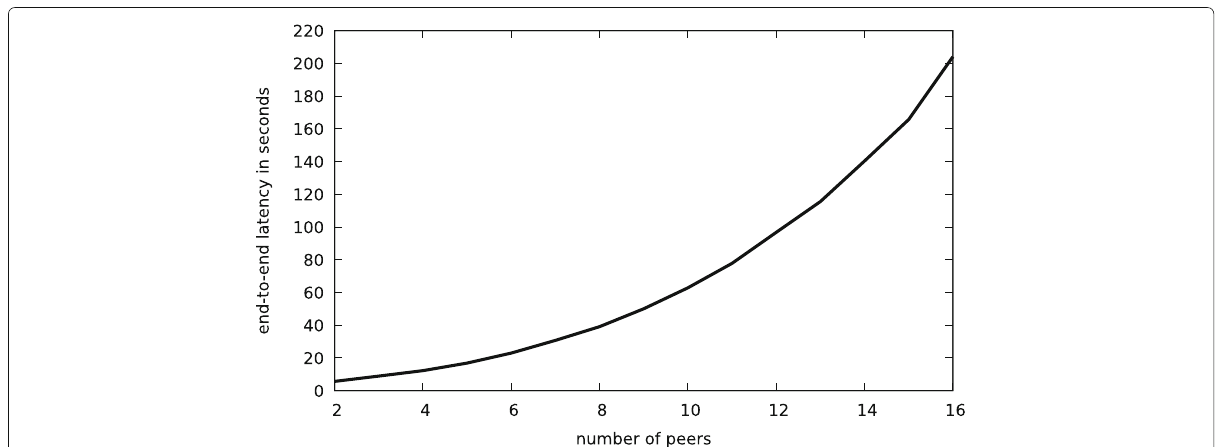
Fig. 10 Latency for BSC with 4 peers on 100 elements of 64 bytes and one malicious peer with the indicated mode. Average over 50 executions